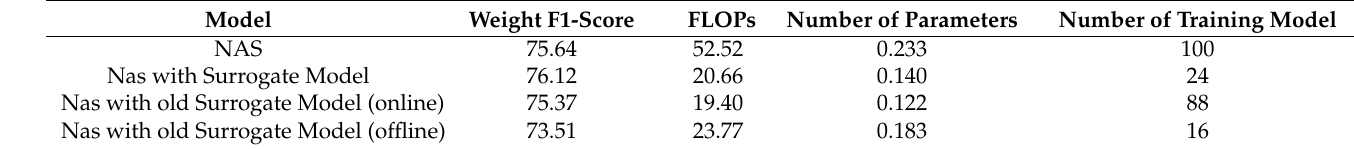
Table 8. Reusability of the surrogate